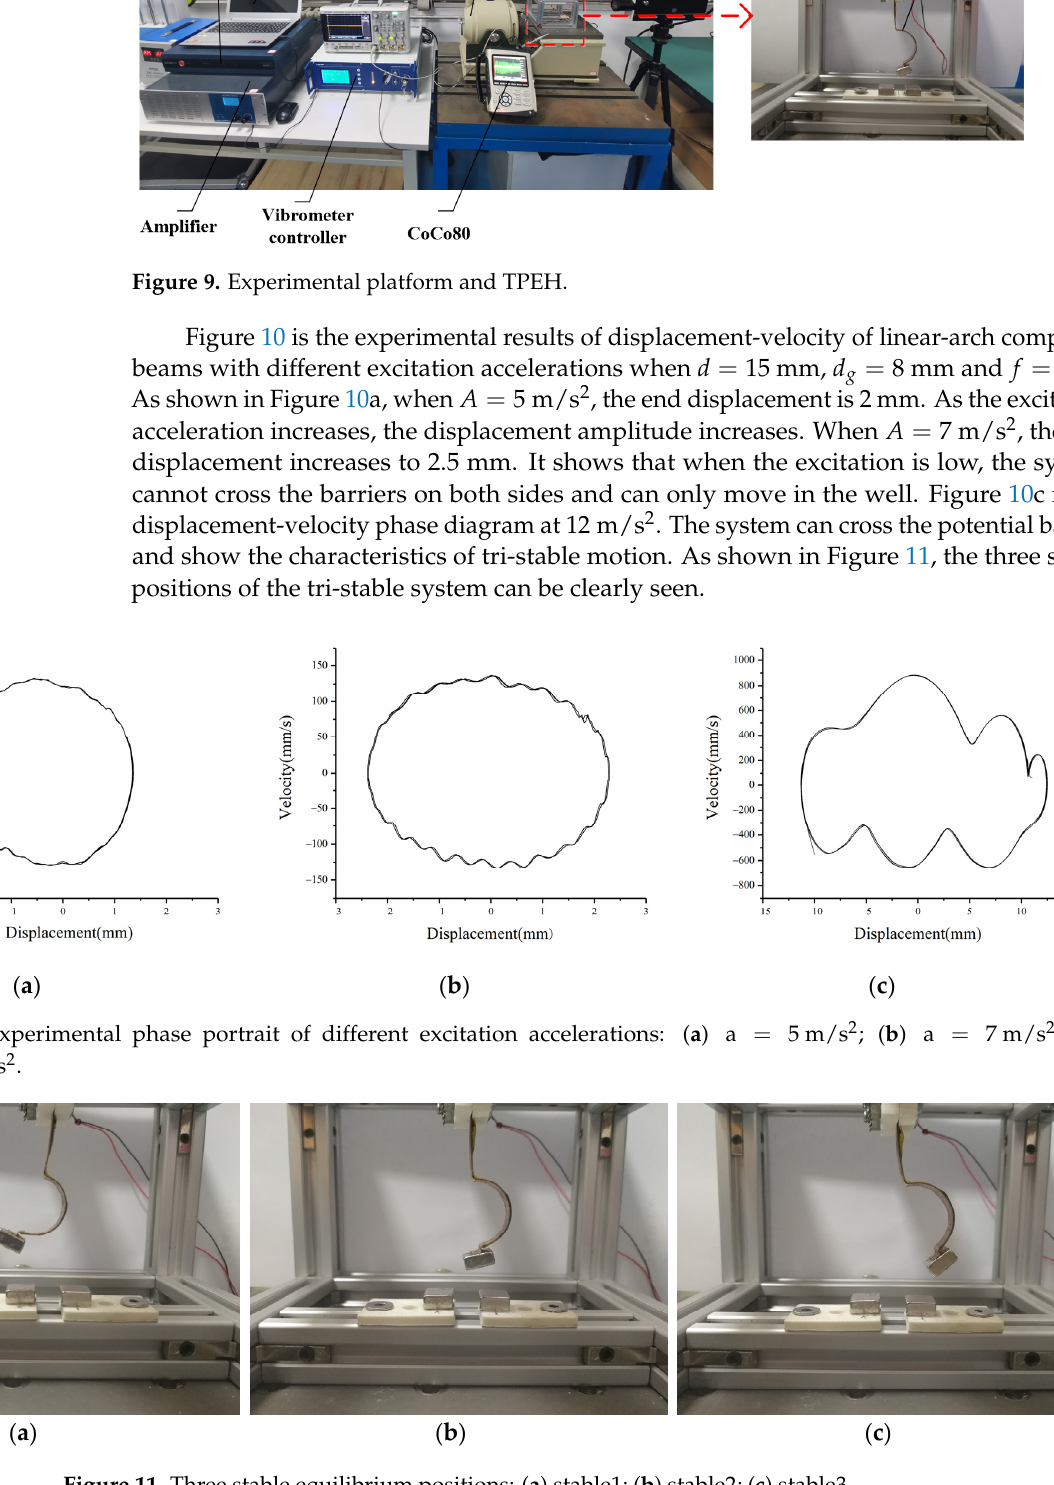
Figure 11. Three stable equilibrium positions: ( a ) stable1; ( b ) stable2; ( c )